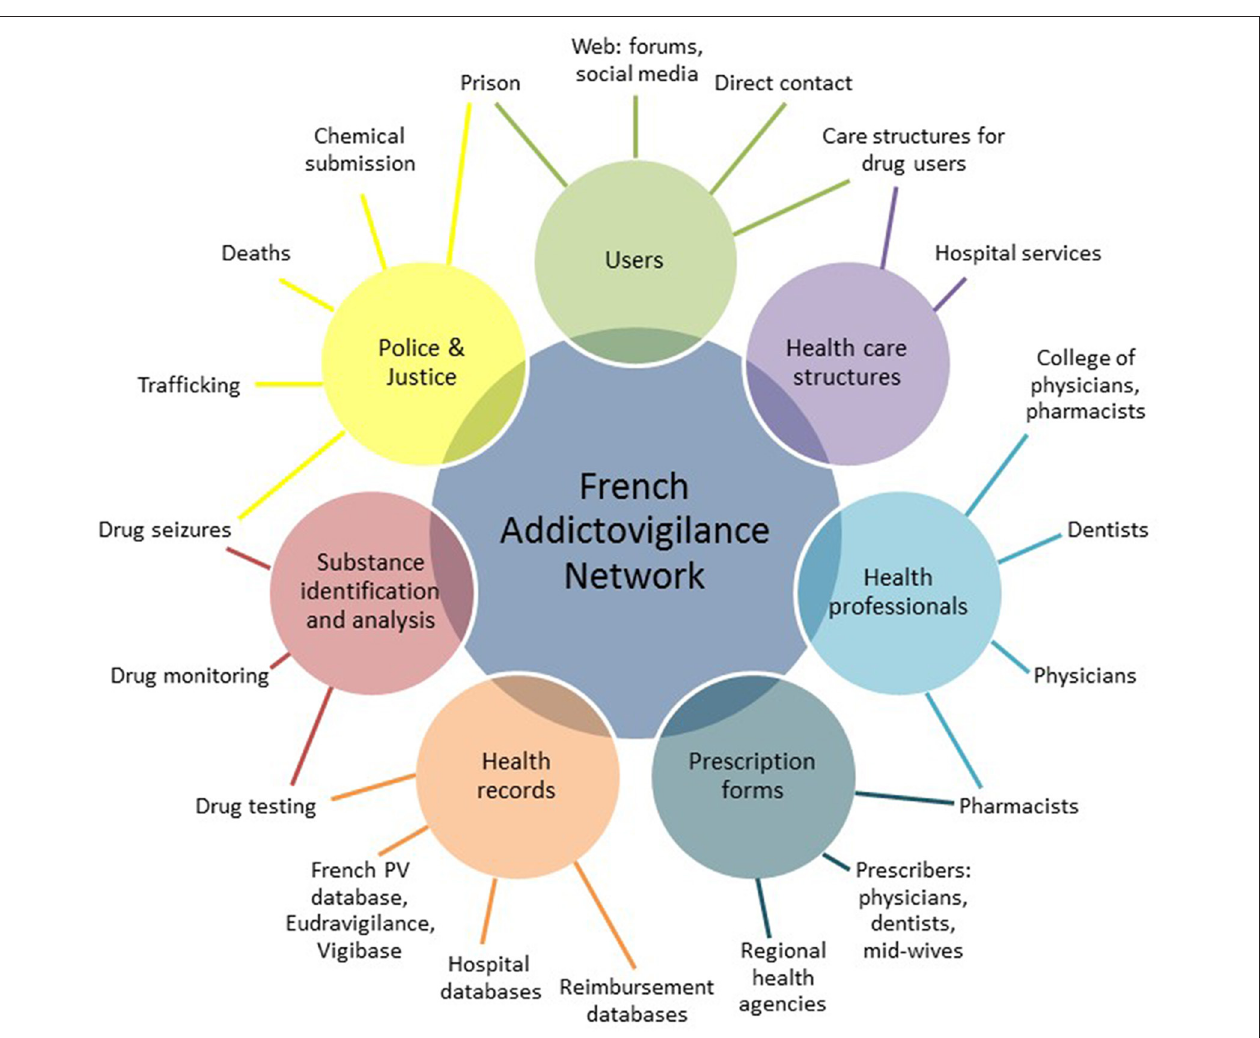
FIGURE 4 | Multidimensional monitoring conducted by the French Addictovigilance Network to detect signals by crossing complementary data